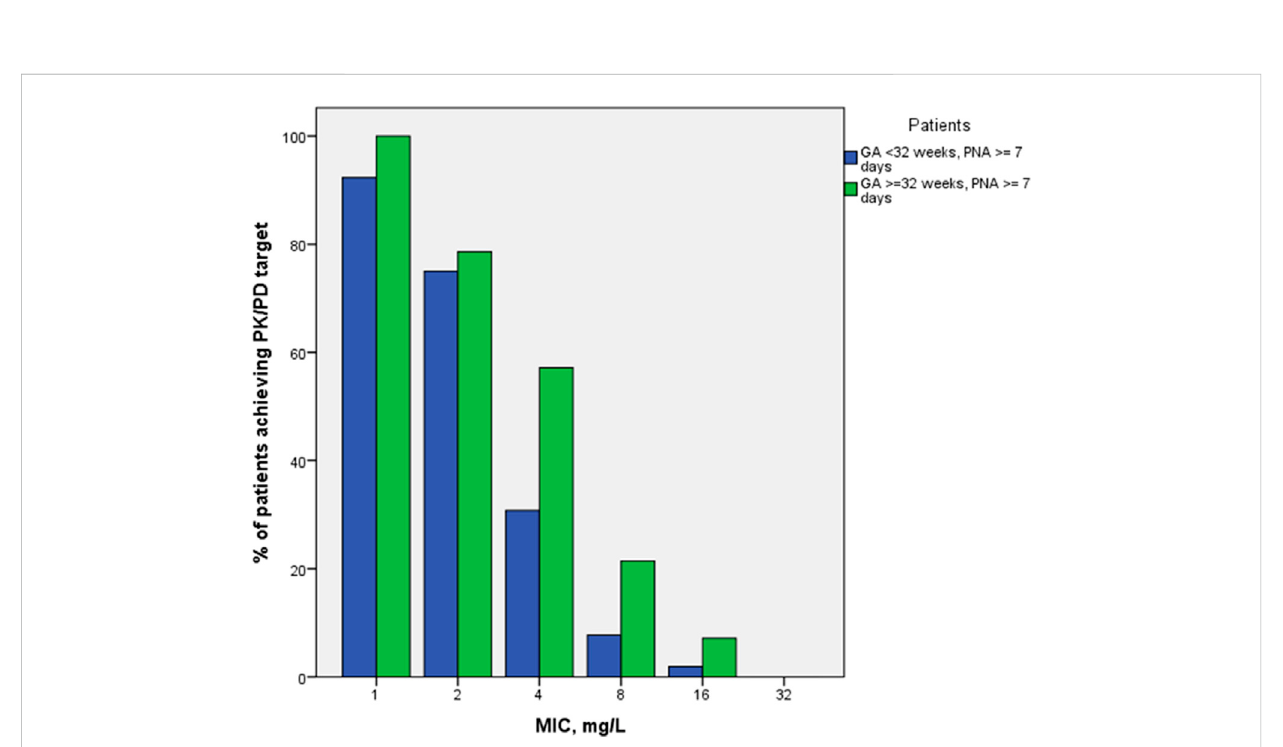
FIGURE 4 Proportions of patients achieving PK/PD indices 100% fT > 1-4xMIC by MIC and by patient GA group (GA < 32 weeks and GA ≥ 32 – 36